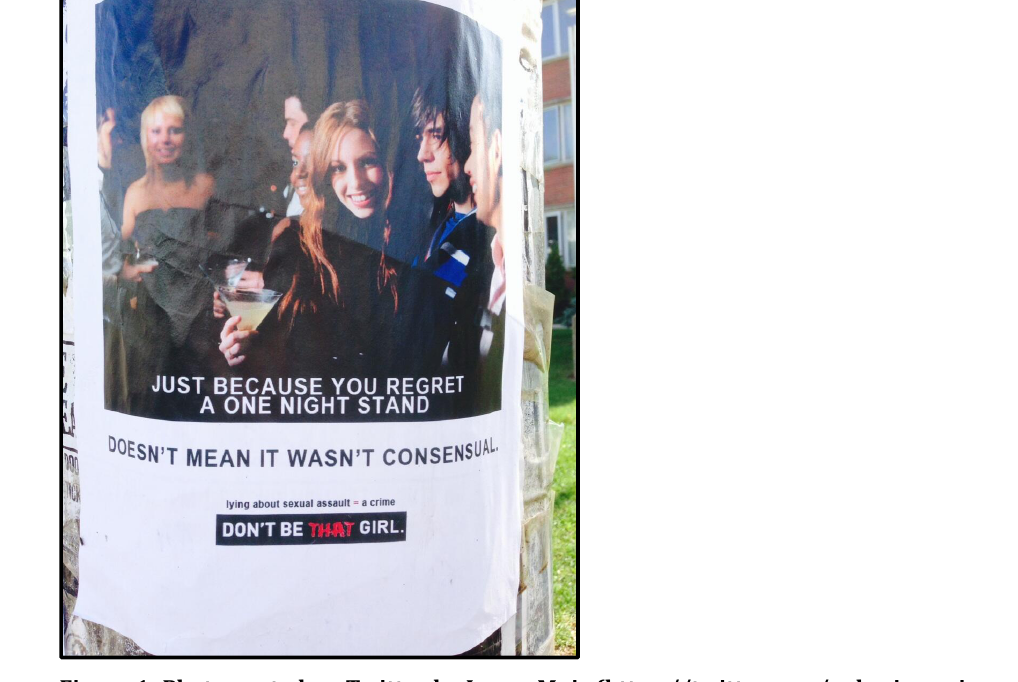
Figure 1: Photo posted on Twitter by James Muir (https://twitter.com/ephraim_quin, accessed 16 September